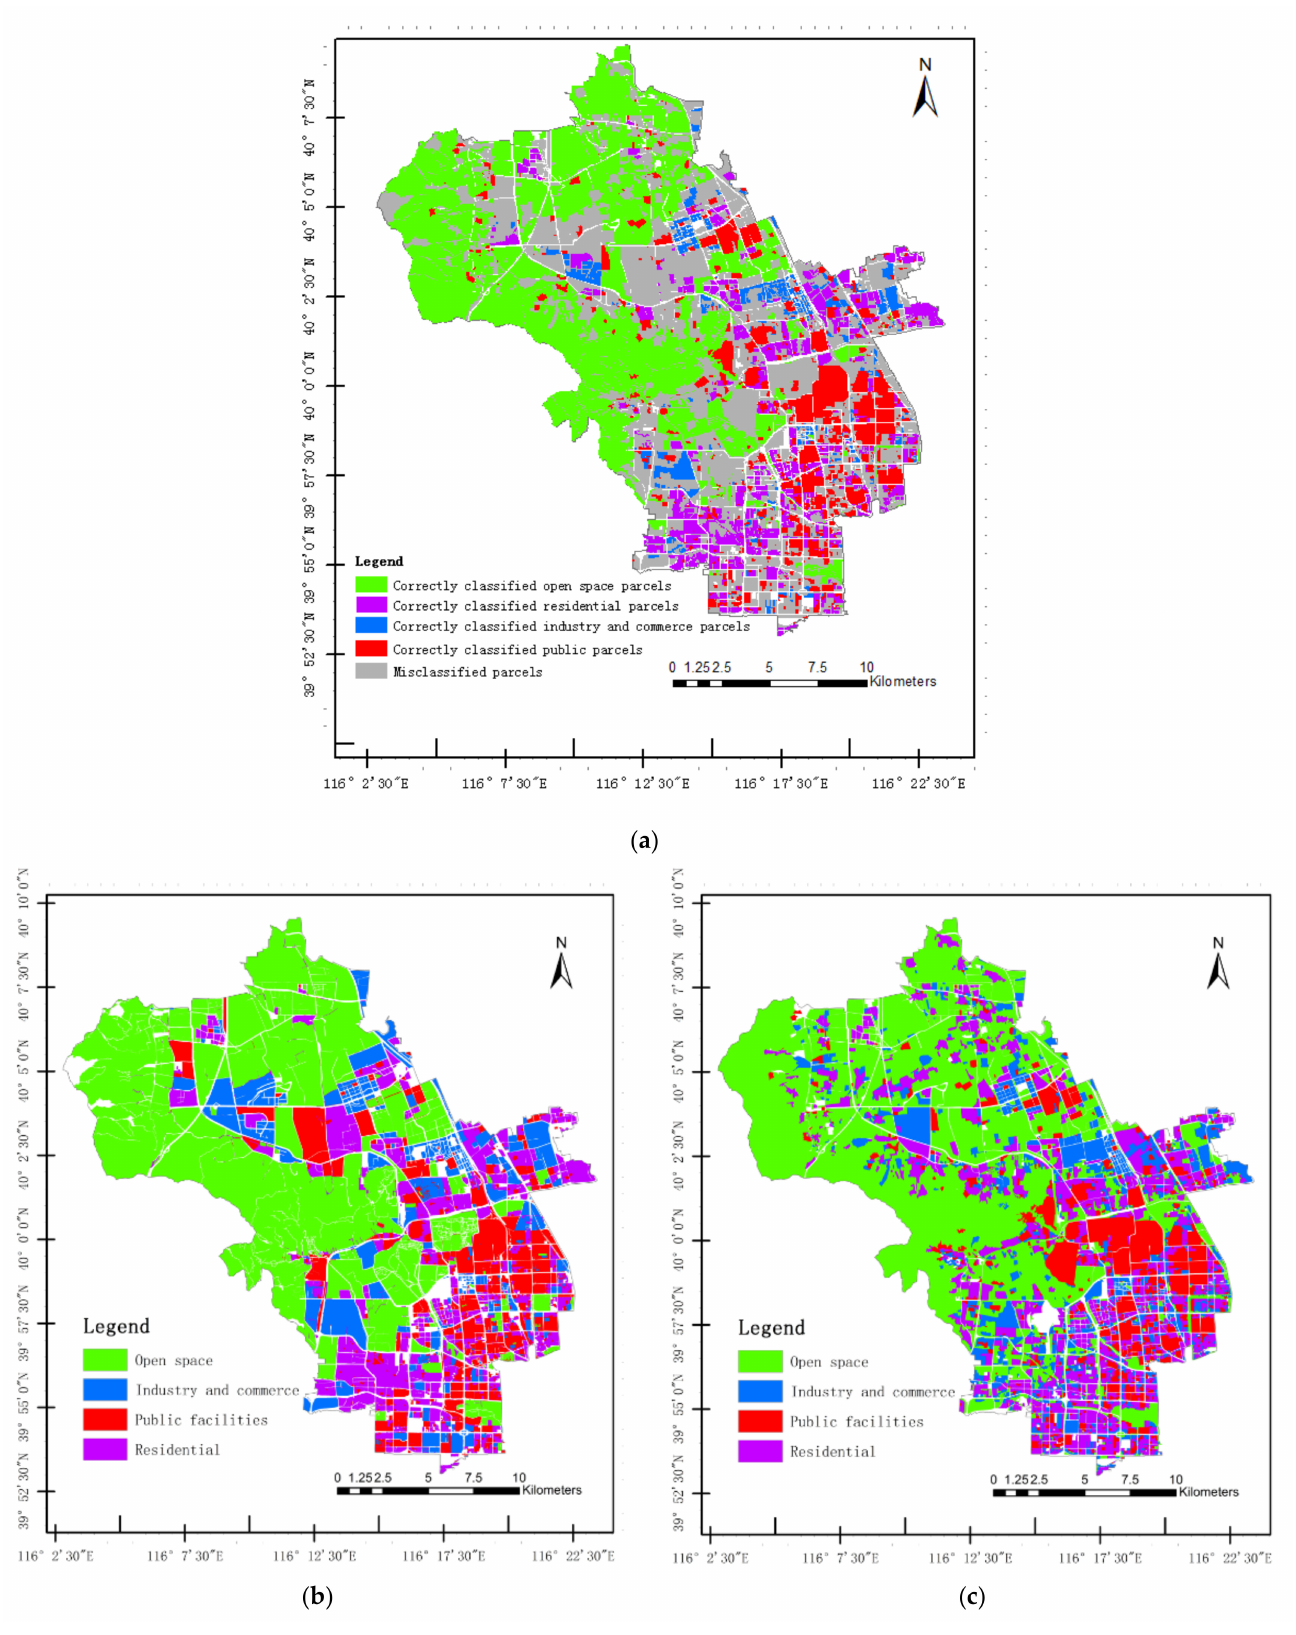
Figure 7. Comparison of the results of UFR identification in this article and the results of visual interpretation: ( a ) correctly classified results, ( b ) the results of UFR in this study, and ( c ) the results of visual